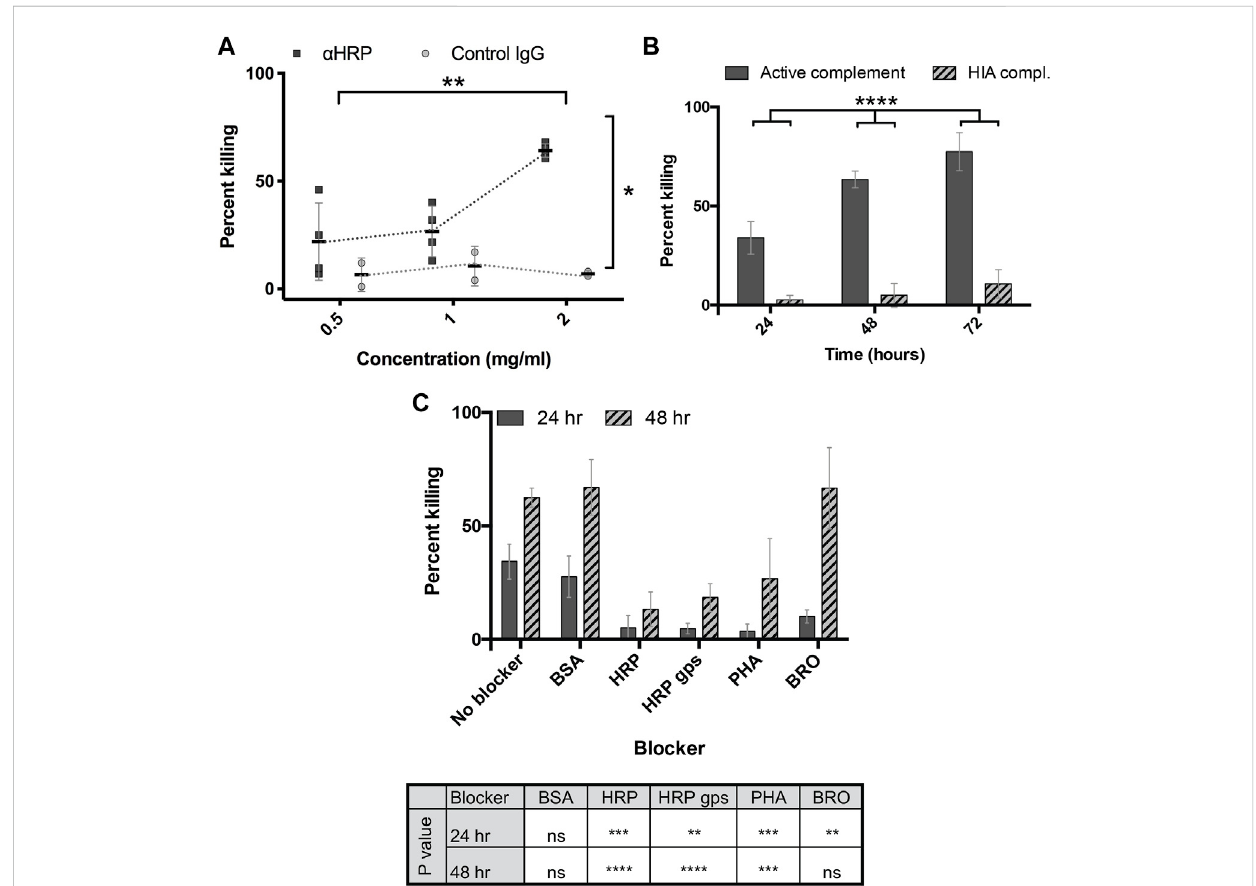
FIGURE 3 Anti-HRPkillsschistosomula invitro. (A) Rabbitanti-HRPandnormalrabbitIgGatindicateddosesincubatedwith3htransformedschistosomulaand active guinea pig complement, and percentage of non-viable out of total schistosomula quanti fi ed at 48 h. 2-way repeated measures ANOVA showed a signi fi cant effect of antibody type and dose. * p < 0.05; ** p < 0.01. (B) Rabbit anti-HRP at 2 mg/mL incubated with 3h transformed schistosomula and active or heat-inactivated (HIA) guinea pig complement, and percentage of non-viable out of total schistosomula quanti fi ed at 24 – 72 h. 2-way repeated measures ANOVA showed asigni fi cant effect of time and complementactivity.**** p < 0.0001. (C) Rabbit anti-HRP at2 mg/mL, pre-incubated withorwithouttheindicatedblockers(50 μ gperwell),incubatedwith3htransformedschistosomulaandactiveguineapigcomplement,andpercentage of non-viable out of total schistosomula quanti fi ed at 24 – 48 h. 2-way repeated measures ANOVA with Sidak ’ s multiple comparisons test showed a signi fi canteffectoftimeandblocker,withthelevelofsigni fi canceforeachblockercomparedtocontrolshowninthetable.ns,notsigni fi cant;** p < 0.01, *** p < 0.001 **** p < 0.0001. BSA, Bovine serum albumin, HRP, Horseradish peroxidase, HRP gps, HRP glycopeptides, PHA, phytohemagglutinin-E, BRO, Pineapple